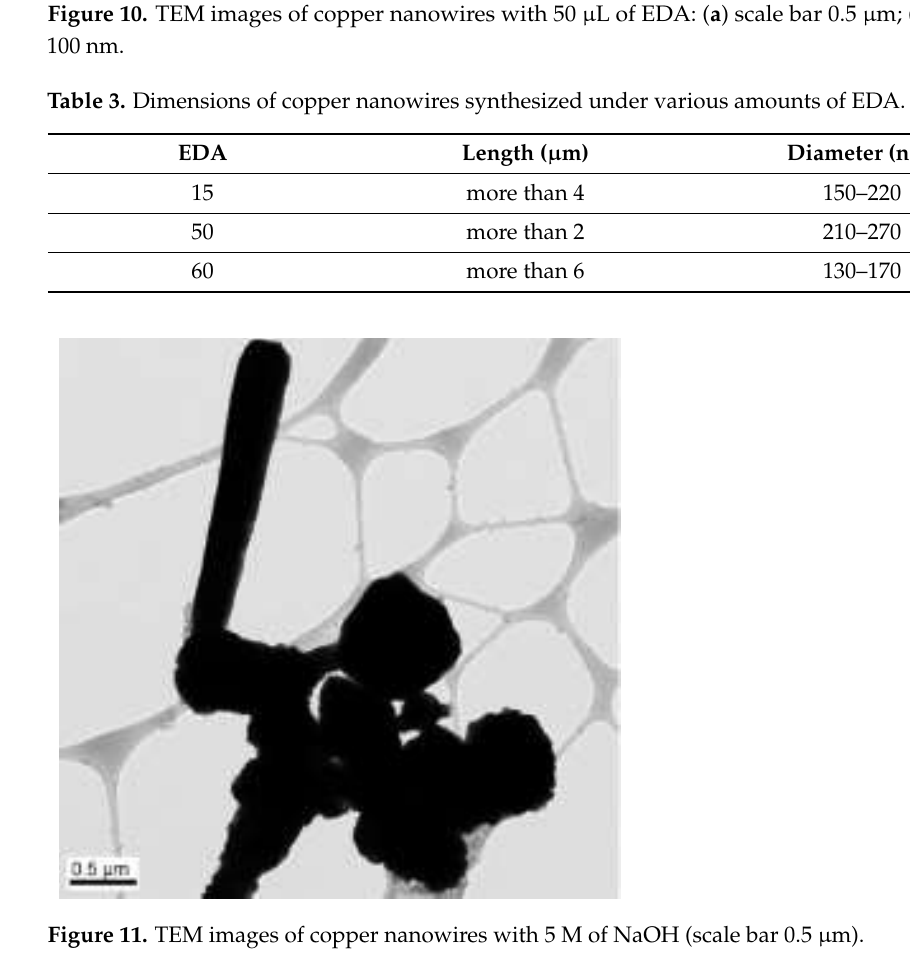
( a ) ( b ) Figure 12. TEM images of copper nanowires with 7 M of NaOH: ( a ) scale bar 1 µm; ( b ) scale bar 0.2 µm. ( a ) ( b ) Figure 13. TEM images of copper nanowires with 9 M of NaOH: ( a ) scale bar 1 µm; ( b ) scale bar 0.5 µm.